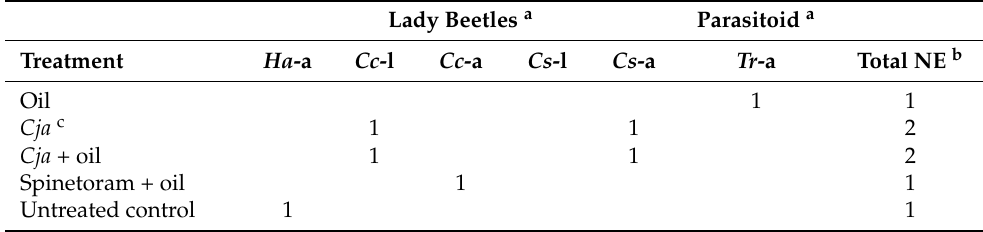
a Ha = Harmonia axyridis ; Cc = Curinus coeruleus ; Cs = Cycloneda sanguinea ; Tr = Tamarixia radiata ; l = larva; a = adult; b NE = natural enemies; c Cja = Cordyceps javanica . 3.1.4. Cordyceps javanica Field Persistence and Pathogenicity